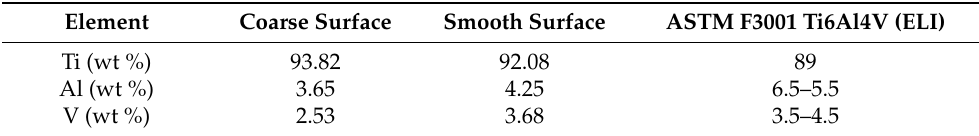
Figure 8. Areas where EDS analyses were performed on typical powder particles with coarse ( a ) and smooth ( b ) surface features. Table 3. EDS elemental compositions of the spheroidised Ti6Al4V powders.